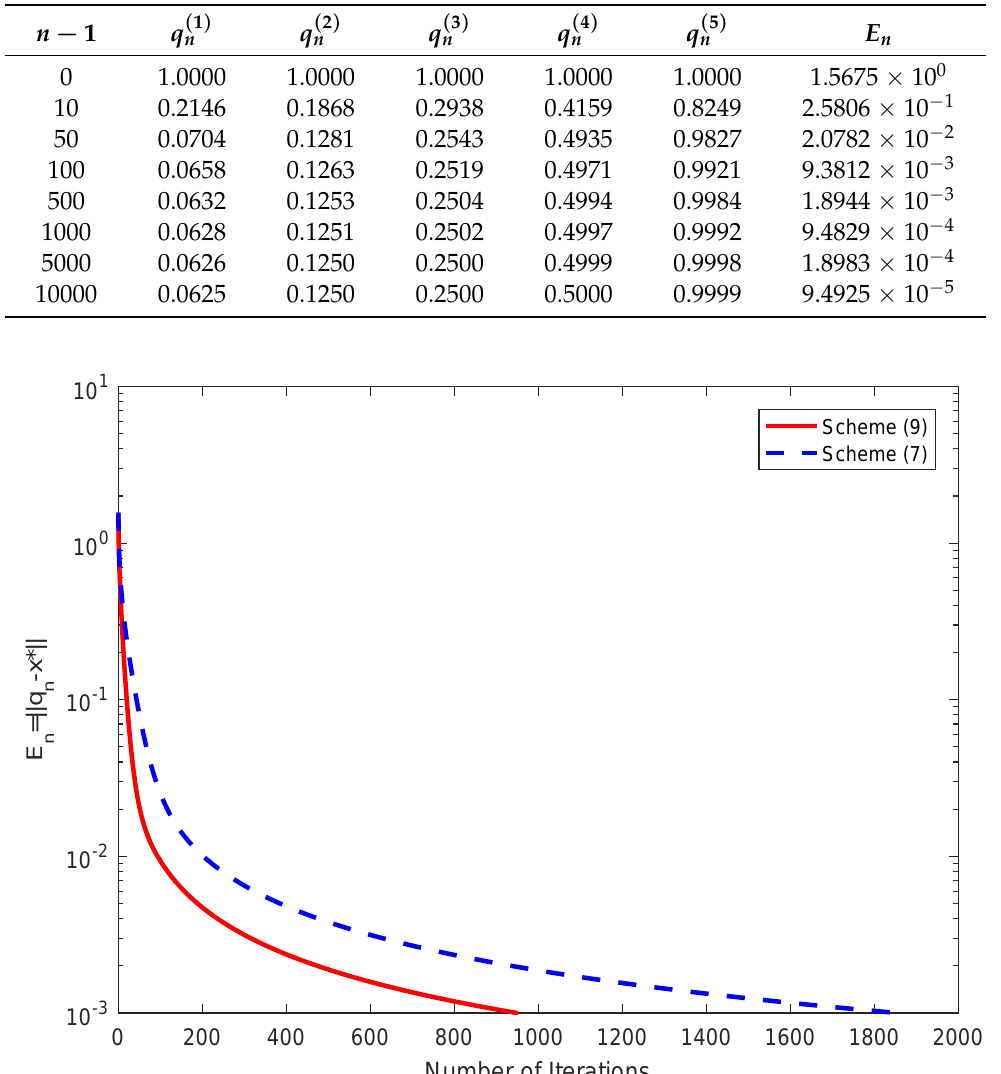
Table 1. Numerical results of scheme (9) as regards Example 1.